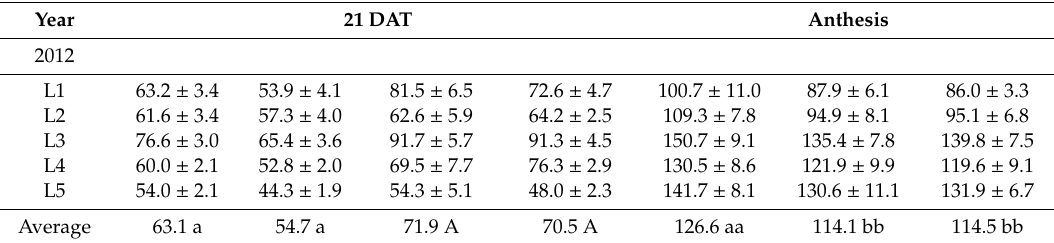
Figure 3. Effects of applied fertilizers on maize harvest index. L1–L5—maize lines. FAA—amino acid foliar fertilizer, FP—phosphate foliar fertilizer, C—control. L1—FAO 200; L2—FAO 300; L3—FAO 500; L4—FAO 600; L5—FAO 600. Averages followed by the same letter do not differ by LSD test at α = 0.05. It is obvious that FM correlated positively with GY in FAA treatment and the control (Figures 4 and 5), having the lowest values when GY is 3–4 t ha − 1 . The higher R2 coefficient was obtained in FAA treatment. LAI was negatively, but insignificantly correlated to GY, while PH did not express any connection with GY. In FP treatment and the control (Figures 6 and 7), significant dependencies between GY and other parameters examined were expressed. LAI and PH correlated linearly with GY in FP, while in the control, R 2 coefficients were slightly higher, with the highest values of LAI and